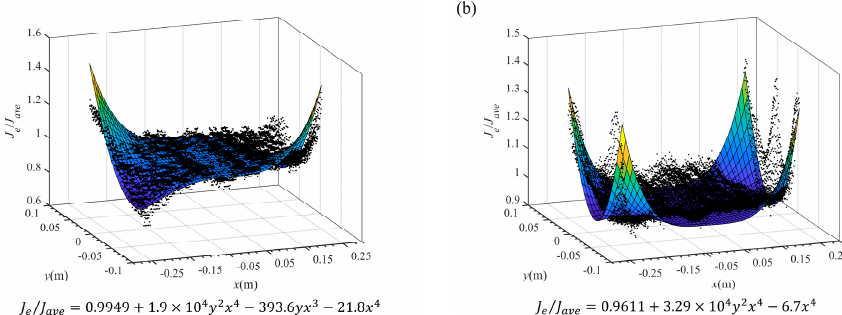
Figure 3. The J e / J ave measurement value surface fitting: ( a ) 9Cr2Mo − asymmetry − 5.0A/mm 2 ; and ( b ) 9Cr2Mo − symmetry − 5.0A/mm 2 .